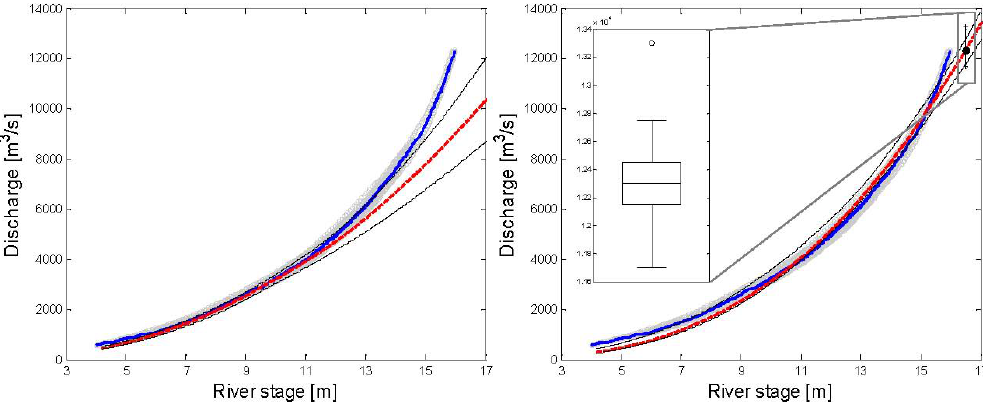
Fig. 6. Cremona cross-section: normal rating-curve (blue line); median rating-curve (red dashed line) for Traditional (left panel) and Constrained (right panel) approaches and corresponding 90% confidence intervals (black lines); for the Constrained approach the diagram also reports the average h max − Q max pair (black point), range of simulated values (bands) and a detailed representation of all h max − Q max pairs (box-plot).